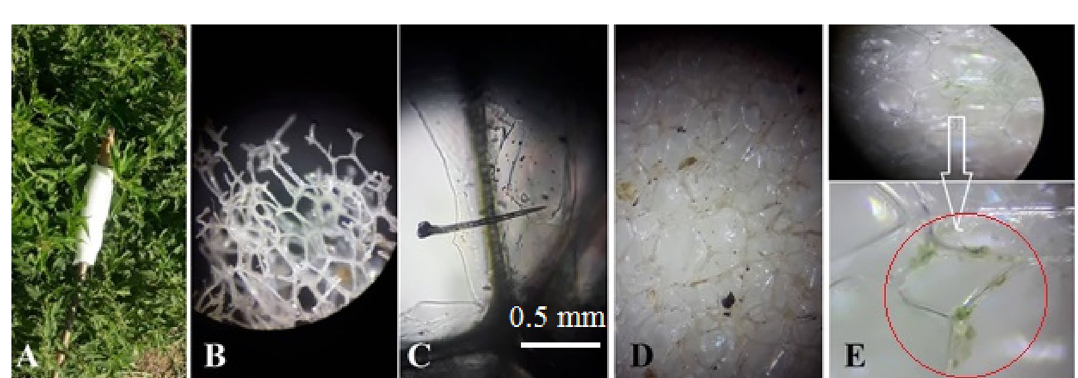
Figure 6. The use of an innovative rod containing the hunting surfaces ) A ) Small nettle hairs, as well as the final liquid of the hairs ( B , C ) sitting on the porous surfaces of the adsorbent and meticulously collected ( D ). The greenish-white liquid that sitting on the pore wall of the studied surfaces having the same biting content and also having the active ingredient of the nettle plant marked in a red circle ( E minutes, which were completely and slowly performed on the leaves and stems (Fig. 1). Each of the rotating cylindrical surfaces had a side area of 376.8 cm 2 and a final volume of 11.7 cm 3 , but the volume of the sponge mass had to be reduced from the maximum total amount. Ecotypes have just been contacted. Immediately after contact, the surfaces used were immediately placed under a stereomicroscope, which was located in the same place, and consequently the desired surfaces were carefully evaluated and photographed. For all four ecotypes on the three surfaces studied, the mean number of fully stuck and sunken needles, broken and sunken needles on the surface tissue, pores torn by plant needles and pores containing pale green liquid were counted and noted (Figs. 4, 5, 6, 7, 8, 9). The results of surveys and data analysis are given in Table 1. Based on Fig. 10. Total venom extraction resulting profile from the studied protocols had more than 10 com- pounds including some important sulfur containing such as: 2,2-dimethyl-propyl 2,2-dimethylpropanesulfinyl sulfone and 2-ethylthiolane, S,S-dioxide, etc. The main components were presented in Table 2. The results showed that sponges can be a suitable texture for hunting nettle hairs for extracting fresh and raw venom. The production of graphs in three replications, as described in Fig. 10, shows the scientific and executive success of the presented protocol. Based on published research, this is the first report of live extraction of nettle medicinal poison.